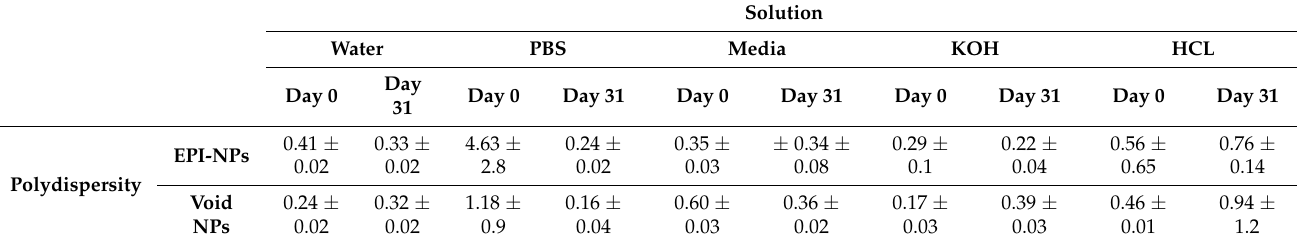
Table 4. Mean polydispersity at day 0 and day 31 for EPI-NPs and void NPs. The data represent the mean average of the five instrument runs for each sample ±